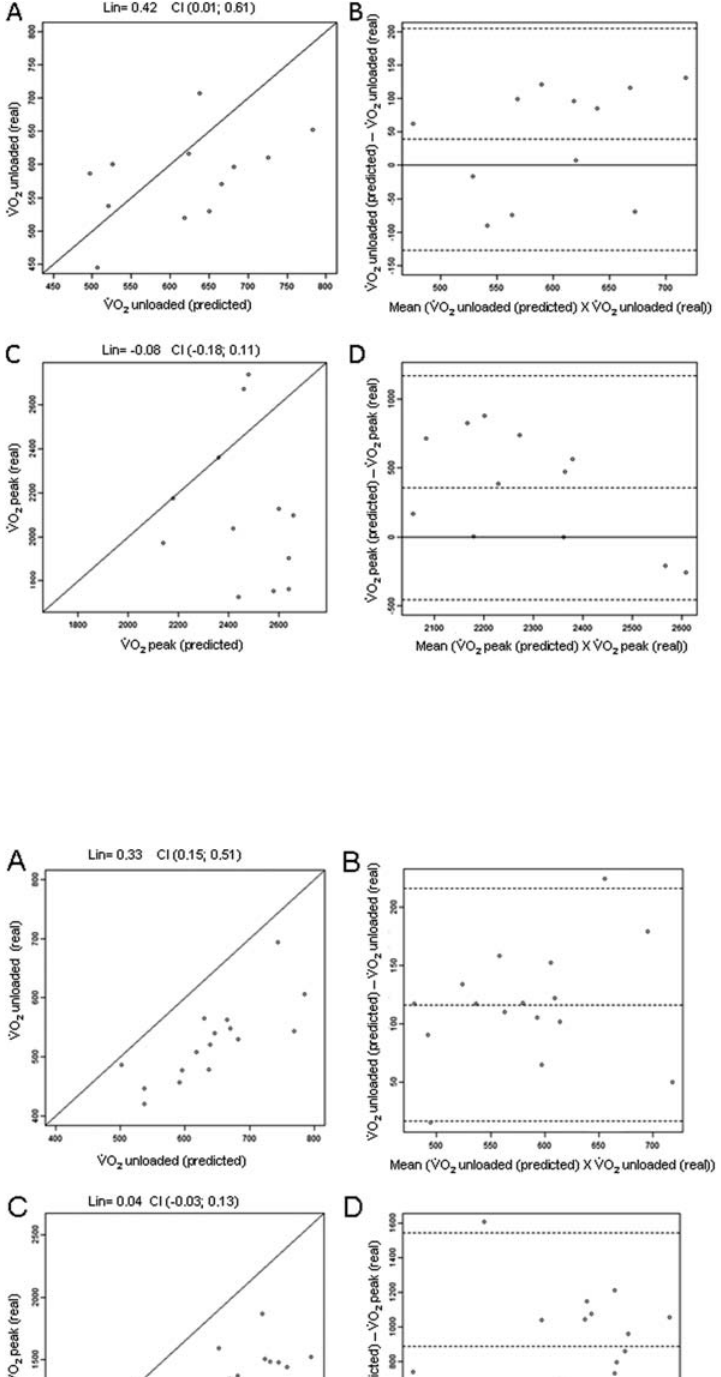
: O 2unloaded ð predicted Þ vs : O 2unloaded ð real Þ ð B Þ in the : O 2unloaded ð real Þ Þ ð C Þ and : O 2peak ð predicted Þ and